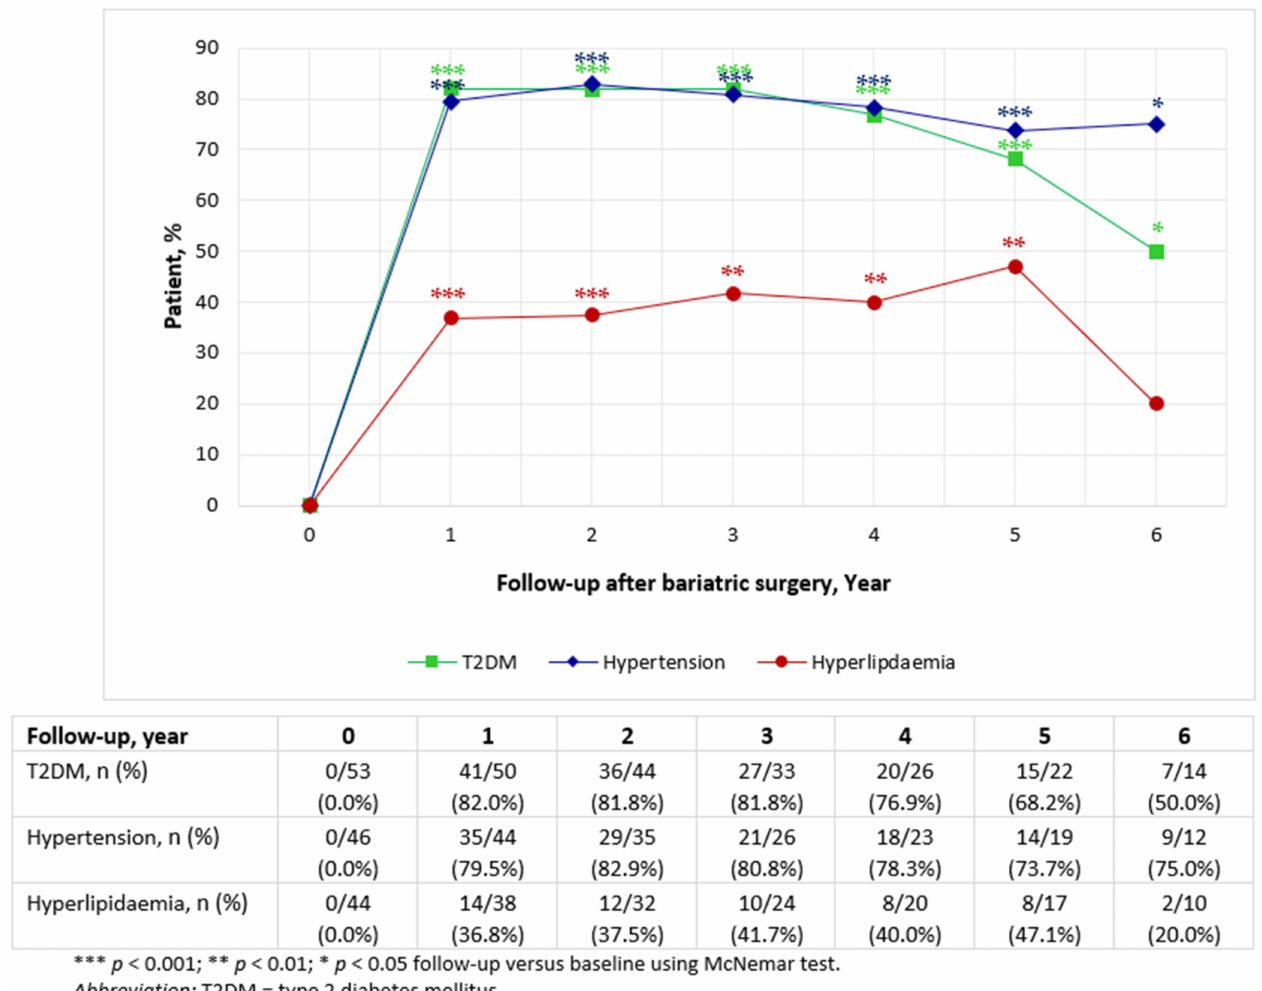
Figure 3. Yearly remission and improvement rates of T2DM, hypertension and hyperlipidaemia following bariatric